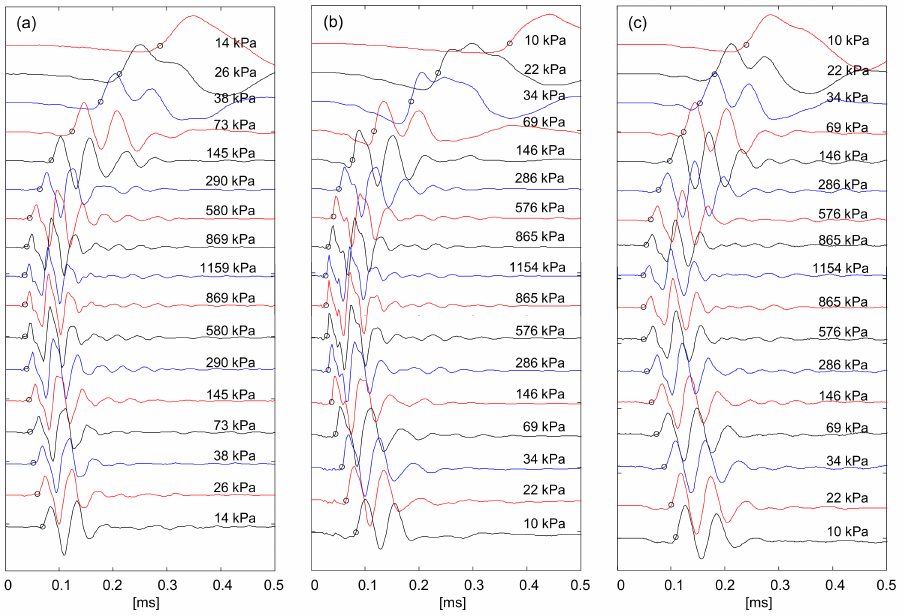
Figure 11. Shear wave signals for Savannah River sands during K o loading and unloading: ( a ) Original field sample; ( b ) Fine-grained soil passed through No. 100 sieve; ( c ) Coarse-grained soil retained on No. 100